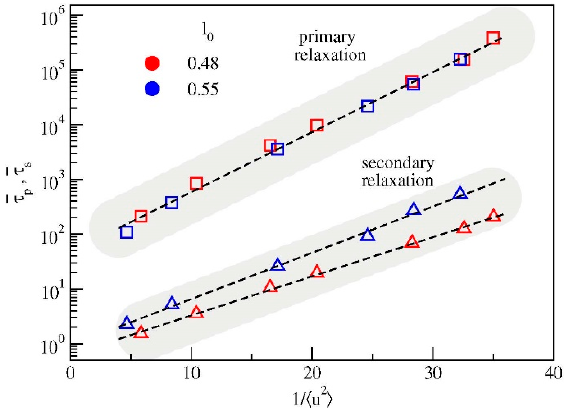
Figure 8. Average relaxation times τ p and τ s versus the inverse Debye-Waller factor. The correlation between the vibrational dynamics and the primary relaxation time τ p is una ff ected by the changes of both the strength and the relaxation time of the secondary relaxation, see Figure 4. Color code as in Figure 1.